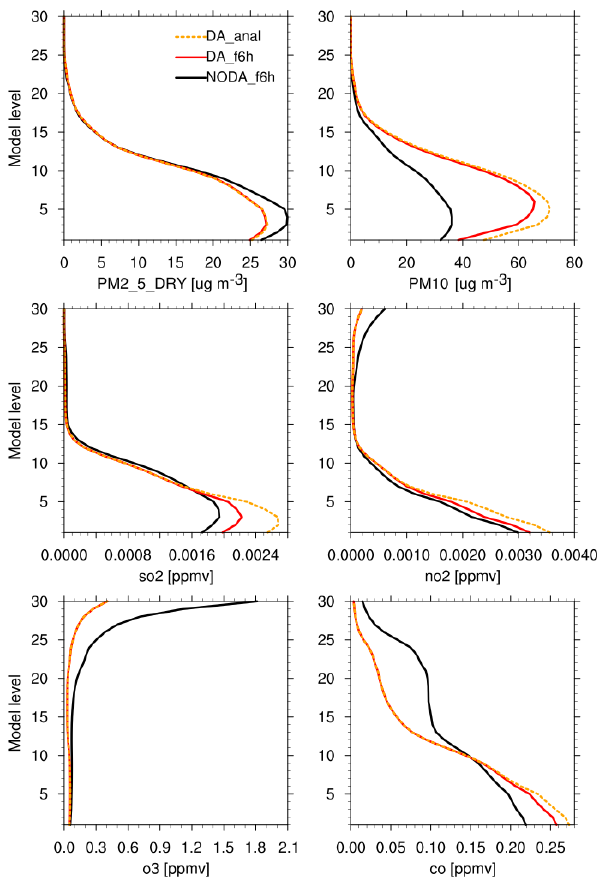
Figure 11. Same as Fig. 10 but for six pollutants assimilated in DA.